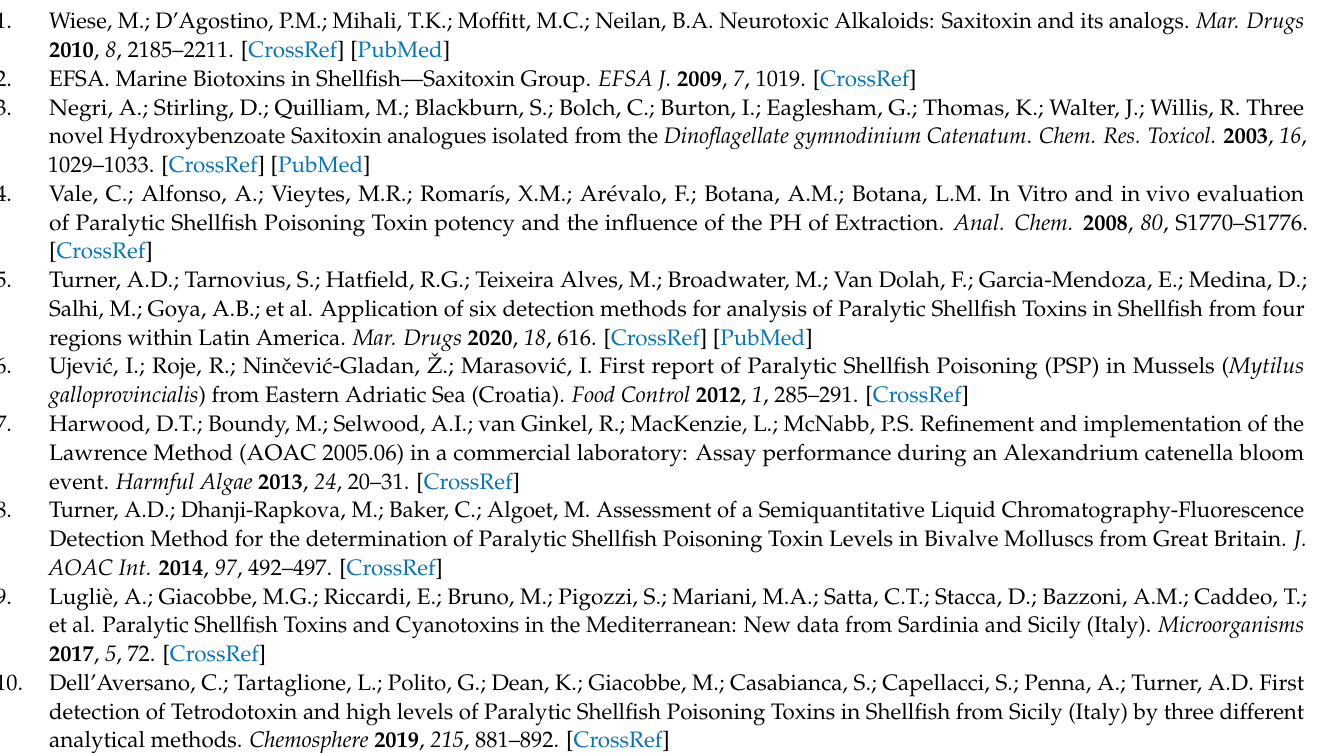
Supplementary Materials: The following are available online at https://www.mdpi.com/article/ 10.3390/molecules27154702/s1, Table S1: Mussels and gastropods sample chromatographic peak areas measured during validation. Table S2: Spiked mussels and gastropods samples recoveries during validation. Figure S1: Group representative toxin selection in case of coelution (Group 1 and 4 listed in Table 4). Figure S2: Standard Mix (MSd mix 7) chromatogram compared with single toxins chromatograms. Identification of first oxidation (in green) and secondary oxidation (in red) product peaks. File S3: Excel data sheet for PSTs screening analysis results